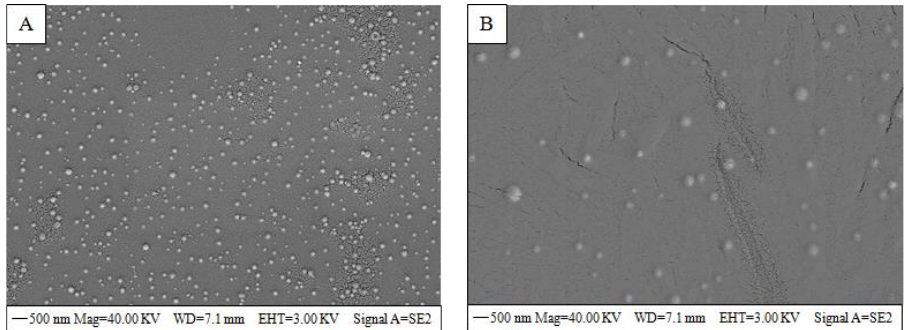
Figure 5. SEM images of ( A ) CSNPs and ( B ) OEO − CSNPs.